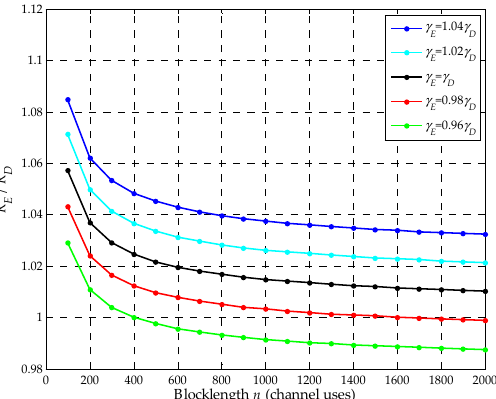
Figure 3. The ratio of R E and R D as a function of the blocklength n .